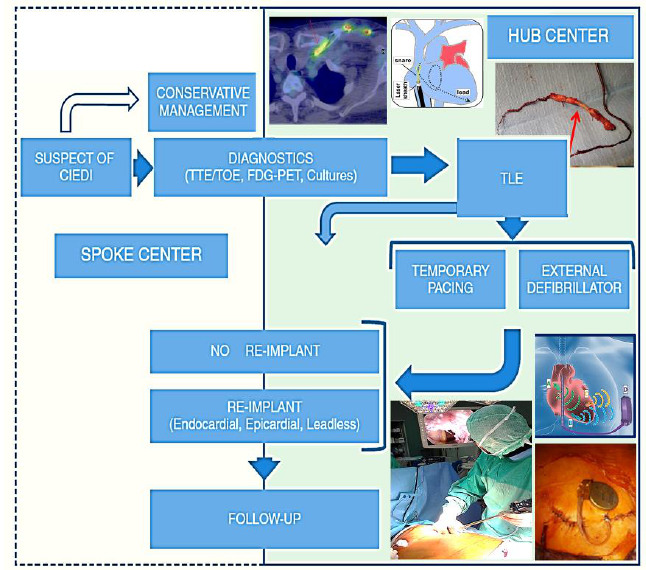
(the so-called “cold closed pocket”) have significantly poorer long-term survival, with mortality of about 60% at 1 year (Figure 4).